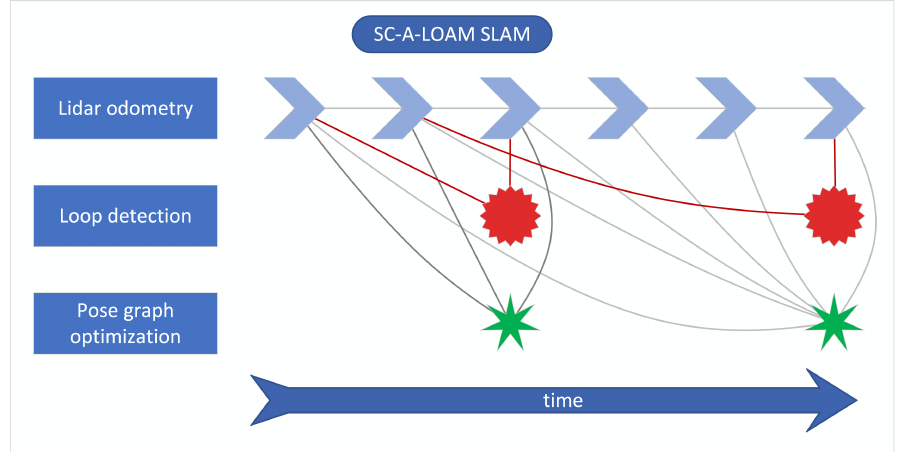
Figure 3. Scheme of utilized SLAM algorithm.